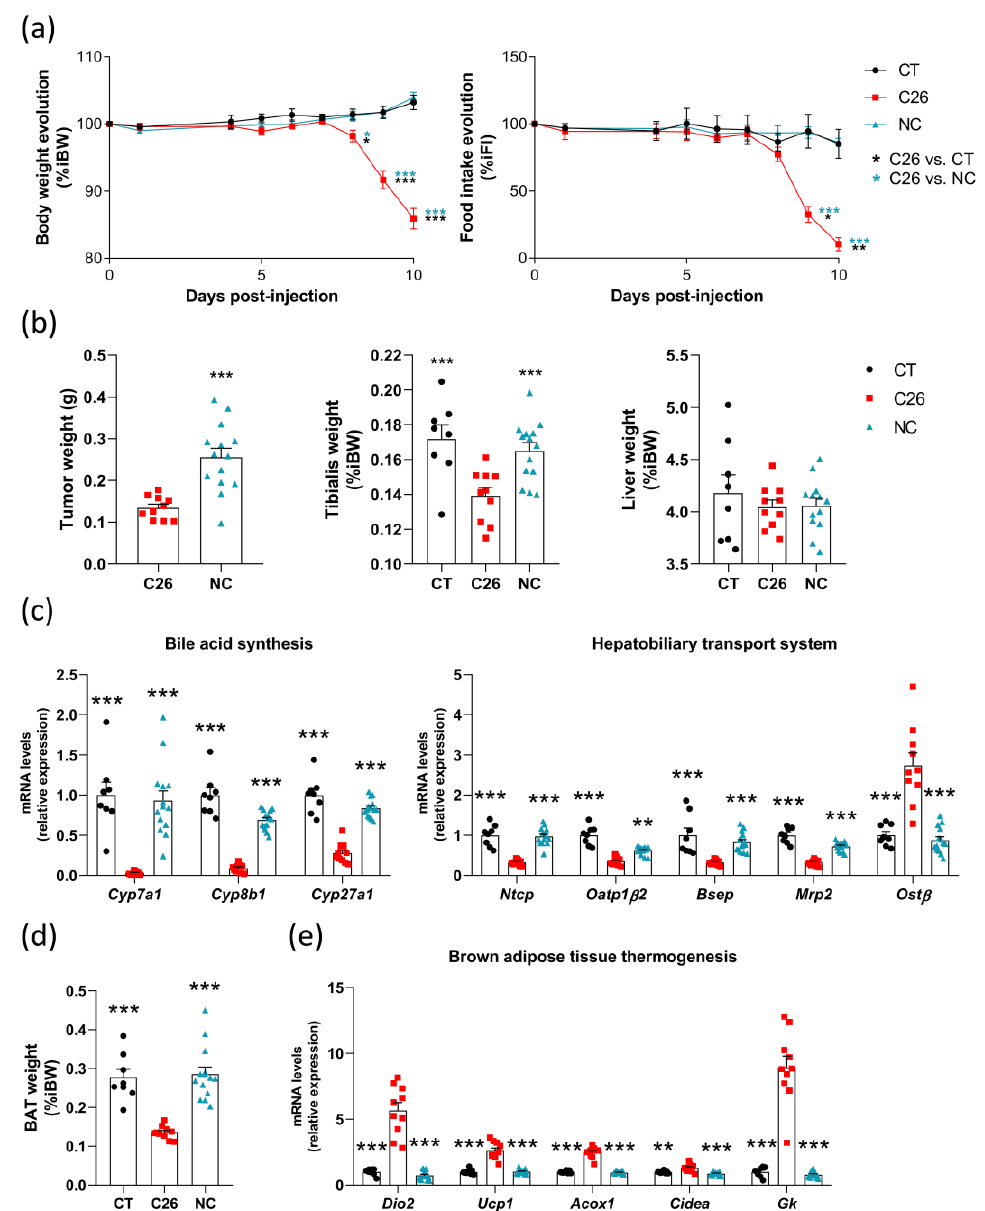
Figure 2. Many alterations in the liver, muscle, and brown adipose tissue are intrinsically related to cachexia and not to the tumor in C26 mice. ( a ) Body weight and food intake evolution in sham-injected mice (CT; n = 8), mice injected with cachexia-inducing C26 colon carcinoma cells (C26 mice; n = 10), and mice injected with non-cachexia-inducing C26 colon carcinoma cells (NC mice; n = 14), expressed in % of initial body weight or food intake. ( b ) Tumor, tibialis, and liver weights of CT, C26, and NC mice. ( c ) Hepatic mRNA expression levels of genes involved in the bile acid synthesis and the hepatobiliary transport system in CT, C26, and NC mice. ( d ) The brown adipose tissue weight of CT, C26, and NC mice. ( e ) mRNA expression levels of genes involved in thermogenesis in the brown adipose tissue of CT, C26, and NC mice. Cyp7a1 , cytochrome P450 family 7 sub-family A member 1; Cyp8b1 , cytochrome P450 family 8 sub-family B member 1; Cyp27a1 , cytochrome P450 family 27 sub-family A member 1; Ntcp , Na(+)/taurocholate transport protein; Oatp1 β 2 , organic anion transporter family member 1B2; Bsep , bile salt export pump; Mrp2 , multidrug resistance-associated protein 2; Ost β , organic solute transporter subunit beta; Dio2 , iodothyronine deiodinase 2; Ucp1 , uncoupling protein 1; Acox1 , acyl-coA oxidase 1; Cidea , cell death-inducing DFFA-like effector A; Gk , glycerol kinase. Data are presented as mean ± SEM, * p < 0.05, ** p < 0.01, *** p < 0.001 vs.